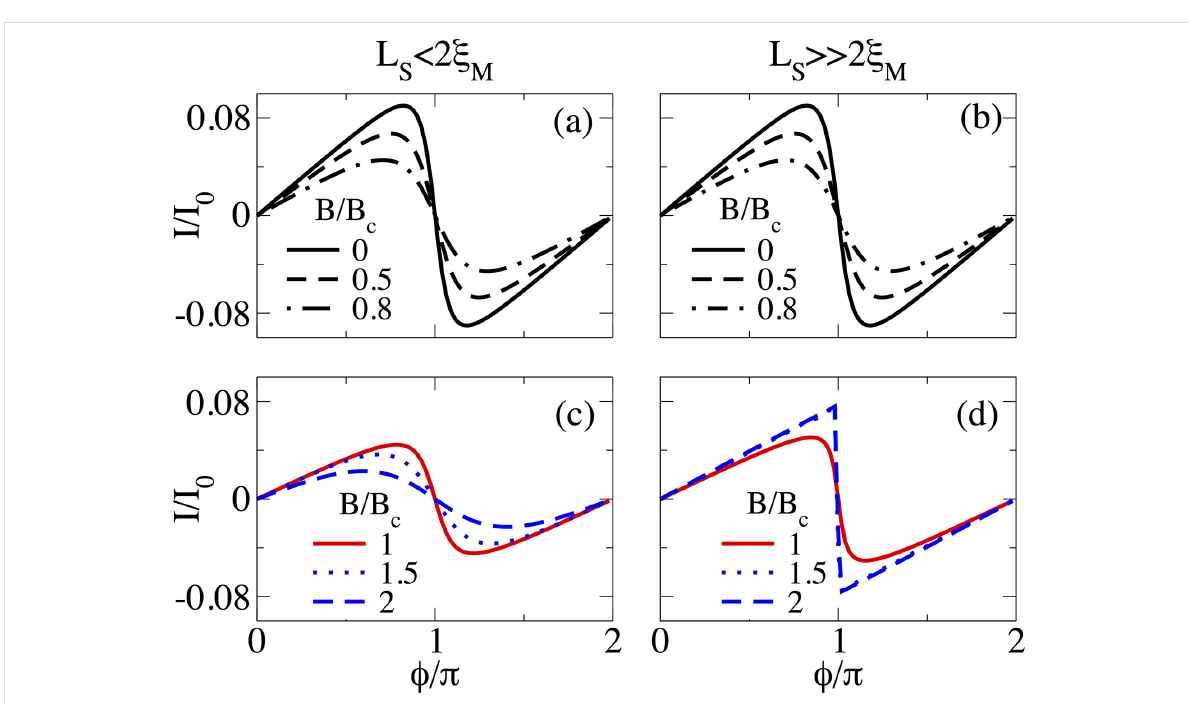
Figure 12: Supercurrent as a function of the superconducting phase difference in a long SNS junction with L N = 2000 nm, for L S = 2000 nm ≤ 2 ξ M (a,c) and L S = 10000 nm 2 ξ M (b,d). Panels a and b show the Josephson current in the trivial phase for different values of the Zeeman field, B < B c , while panels c and d correspond to different values of the Zeeman field in the topological phase, B ≥ B c . In this case the magnitude of the supercur- rent is reduced, an effect caused by the length of the normal